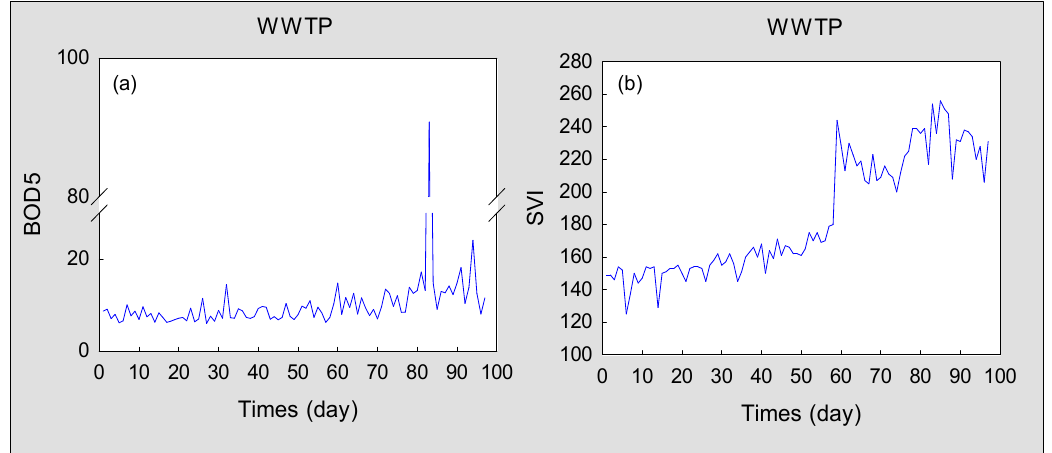
Figure 5. Schematic layout of a real full-scale wastewater treatment process (WWTP).